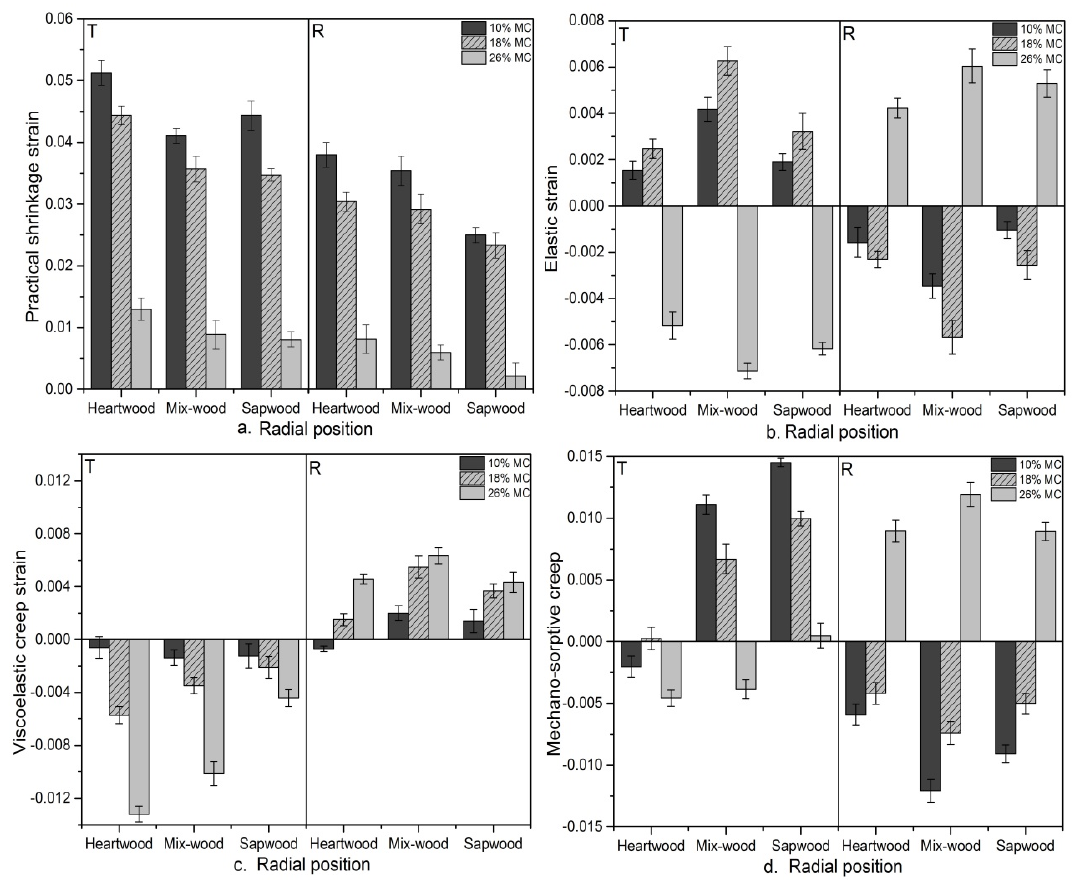
Figure 4. Effect of radial position and moisture content on drying strains for tangential and radial directions. ( a ) Practical shrinkage strain; ( b ) Elastic strain; ( c ) Viscoelastic creep strain; ( d ) Mechano ‐ sorptive creep. T indicates Tangential; R indicates Radial.